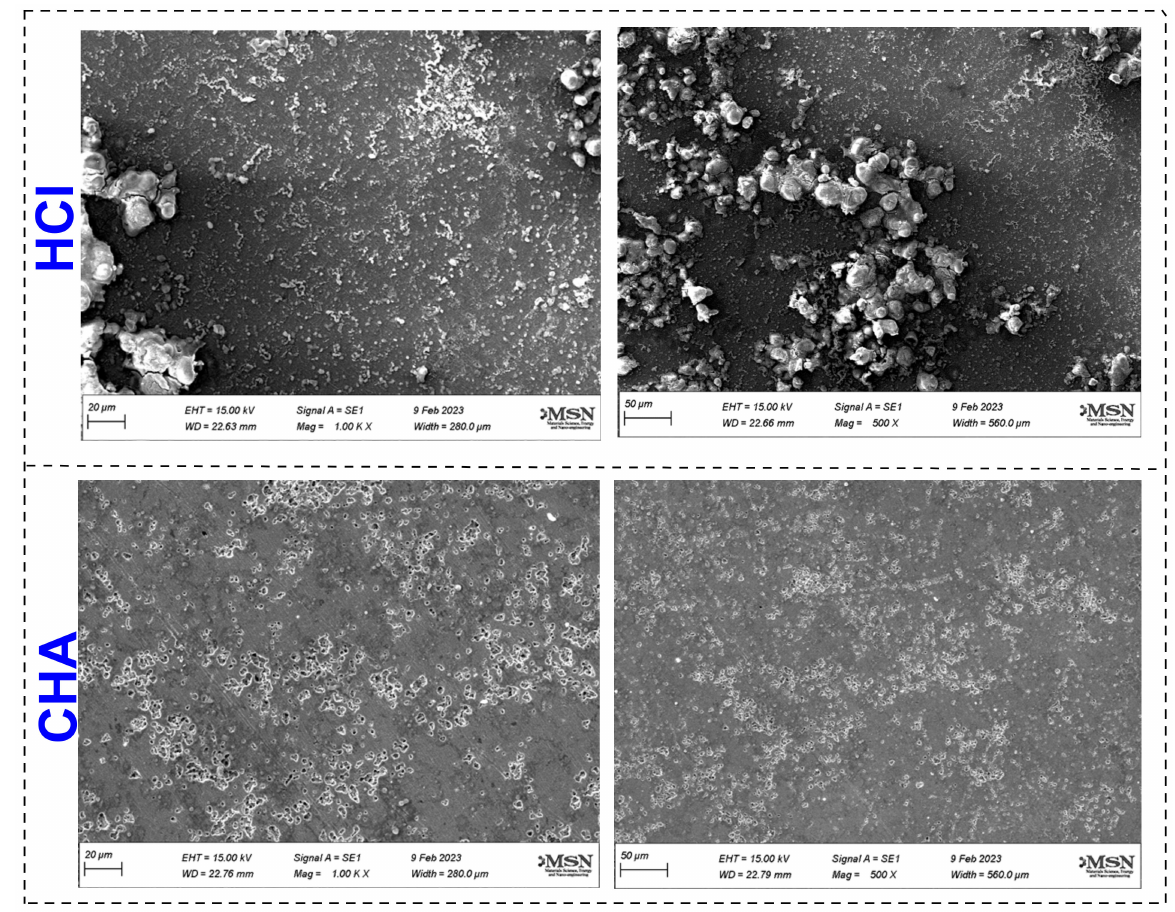
Figure 8. SEM images of the mild steel surface in the absence and presence of 800 mg/L of the plant extract CHA Artemisia herba-alba